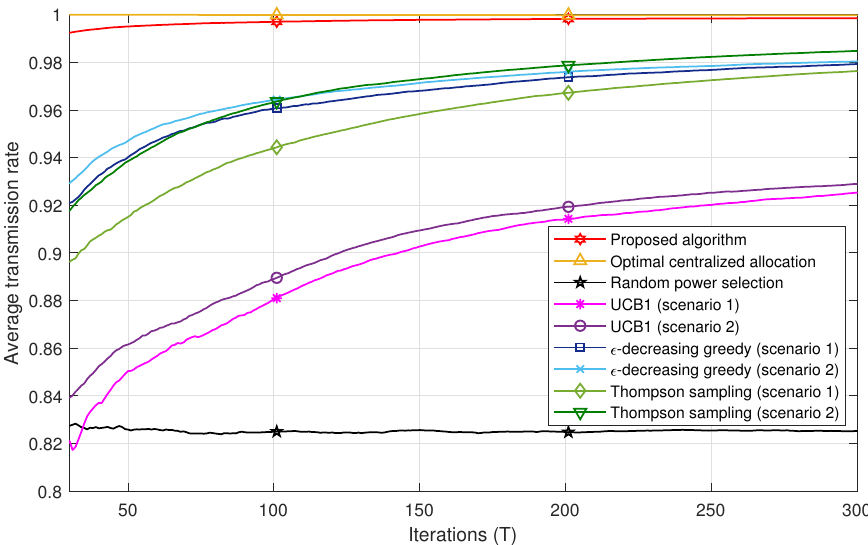
Figure 6. Successful transmission rate comparison for all algorithms in Scenarios 1 and